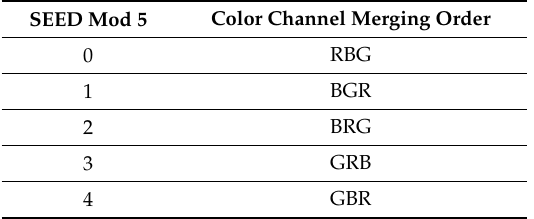
Figure 4. Matrix permutation in video frame: ( a ) permutation list—image processing module permutates the video frame based on permutation list; ( b ) matrix permutation—image processing module permutates rows and columns using every two elements from permutation list; and ( c ) permutated frame. Table 2. Example of color channel reordering